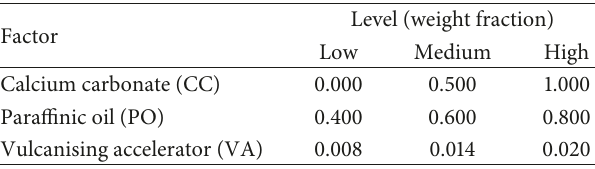
Table 2: Factors and levels (weight fraction) adopted for the 3 3 − 1 fractional factorial design used to define EPDM rubber